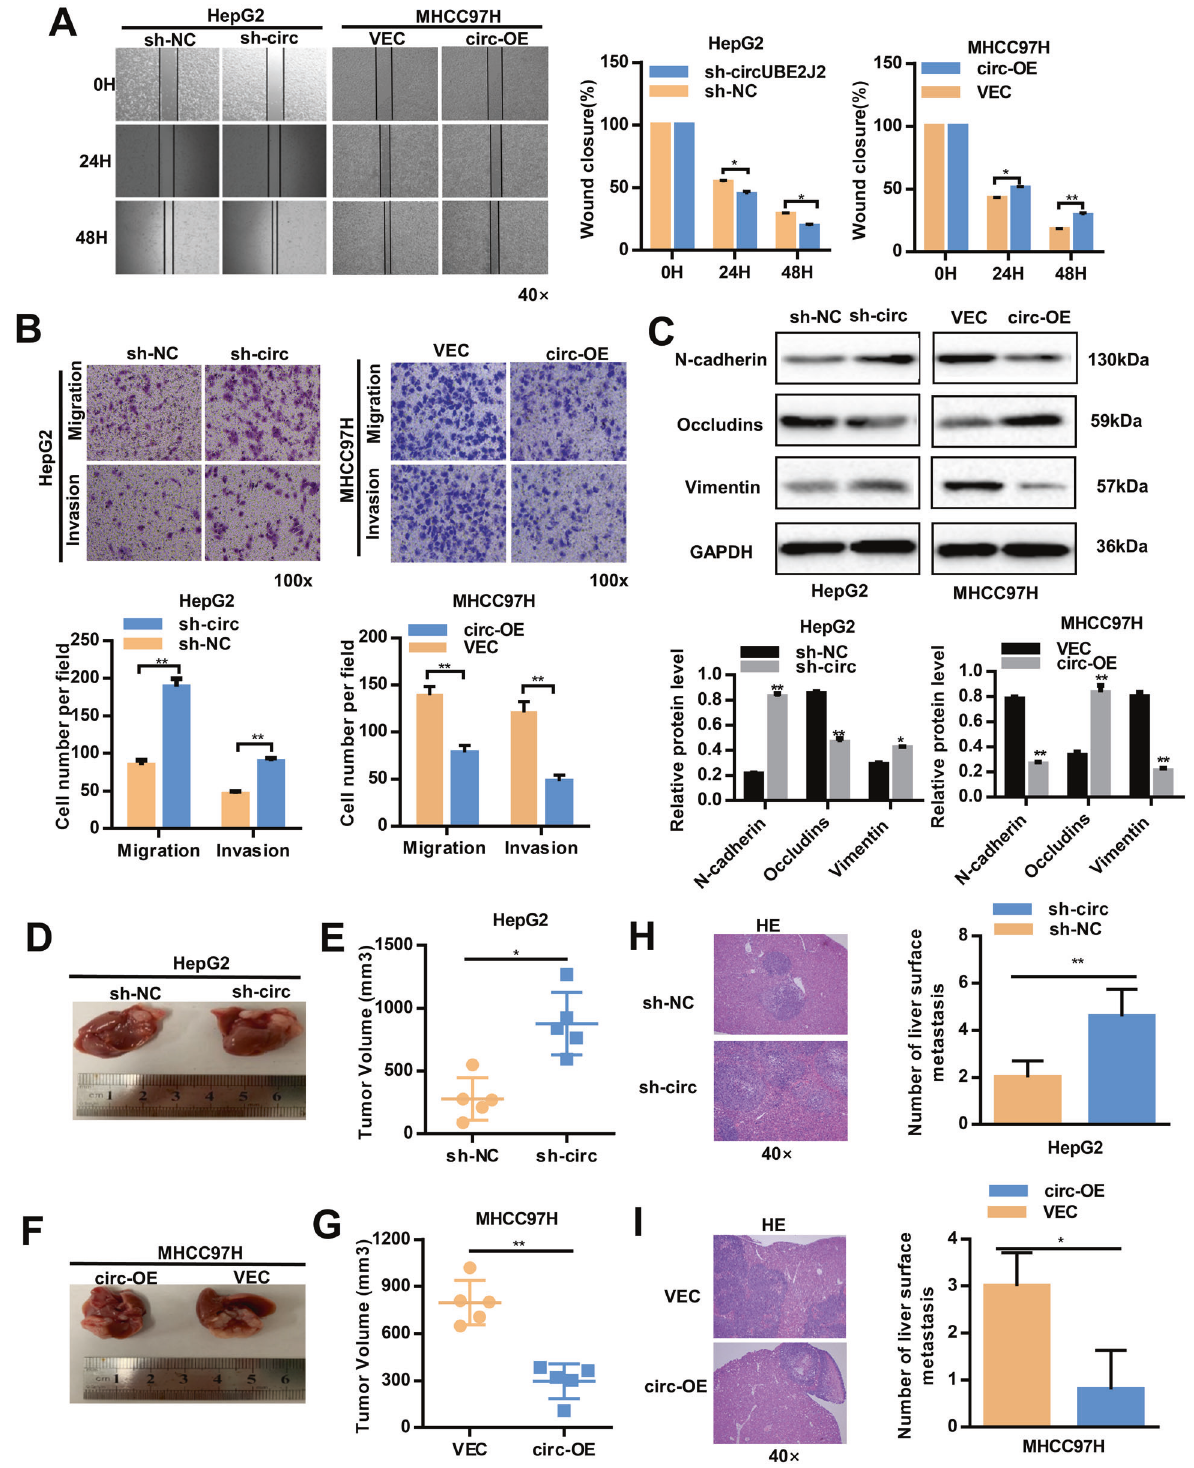
Fig. 3 Downregulation of circUBE2J2 promoted HCC migration both in vitro and in vivo. A The wound healing of HCC cell. B Cell migration and invasion were assessed in both HepG2 and MHCC97H cells using transwell assays. C Western blot analysis for the relative levels of EMT- relevant protein expression in HepG2 and MHCC97H cells. D – I Tumor growth in HCC cells with the forced expression of circUBE2J2 was investigated by nude mice orthotopic tumor models. In orthotopic model mice, representative images of the liver ( D , F ). The size of the largest visible liver nodule was measured ( E , G ). Quanti fi cations of visible surface liver metastatic nodules ( H , I ). Data are presented as mean ± SD; * p < 0.05; ** p < 0.01; NS no signi fi cance. OE overexpression; sh-circ transfected with lentivirus for circUBE2J2-speci fi c shRNA; sh-NC transfected with control